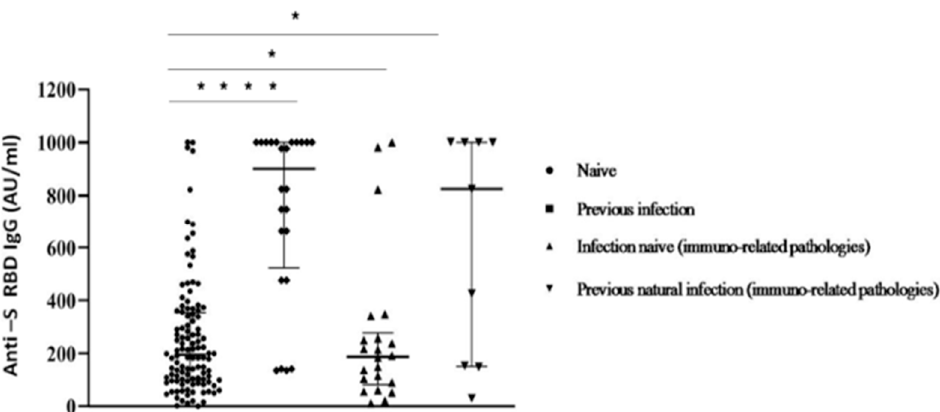
Figure 3. Serological responses after two doses of BNT162b2 mRNA vaccine. ( A – D ) Spearman’s correlation of post vaccine anti-S RBD antibodies levels and age, gender in infection-naive (( A ), females; ( B ), males) and previously infected (( C ), females; ( D ), males) subjects with superimposed linear regression lines (95% confidence interval).